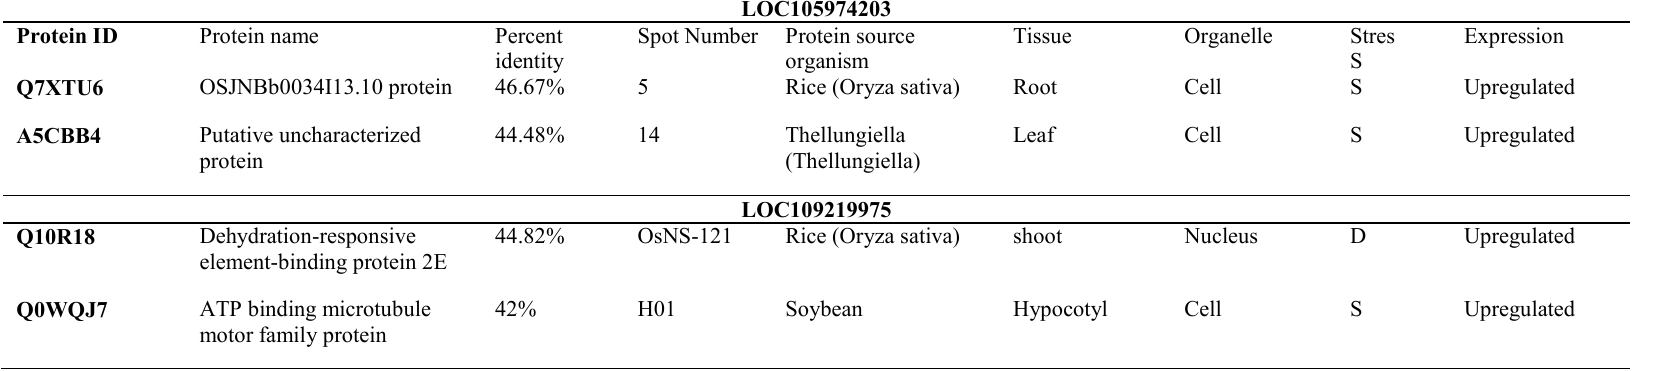
Table 3 . The most identical proteins to our target proteins in response to abiotic